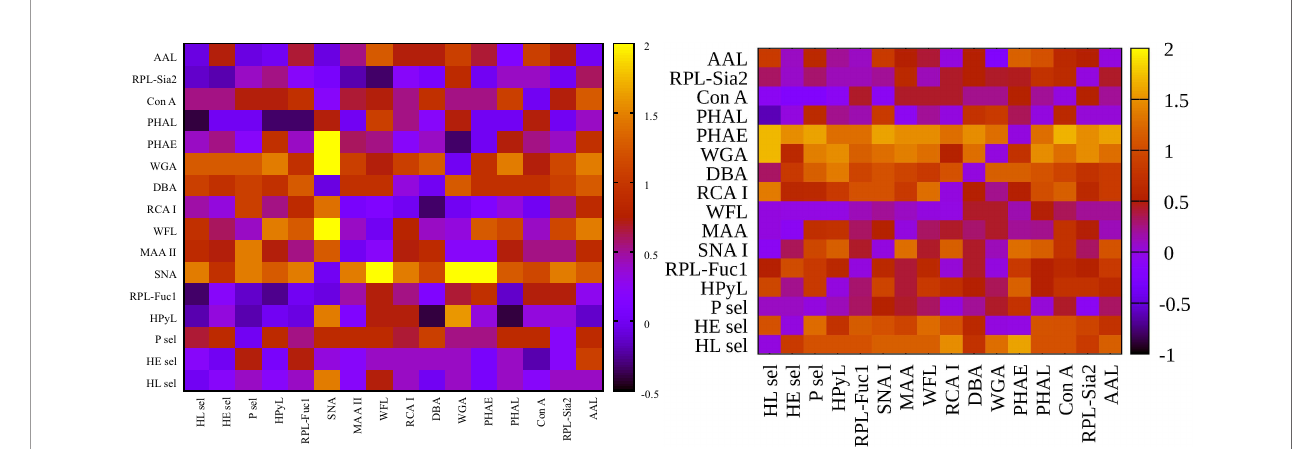
FIGURE 3 | Heat maps for net reclassi fi cation improvement (NRI) (>0) analysis showing hY vs. hO (left) and hO vs. CRC